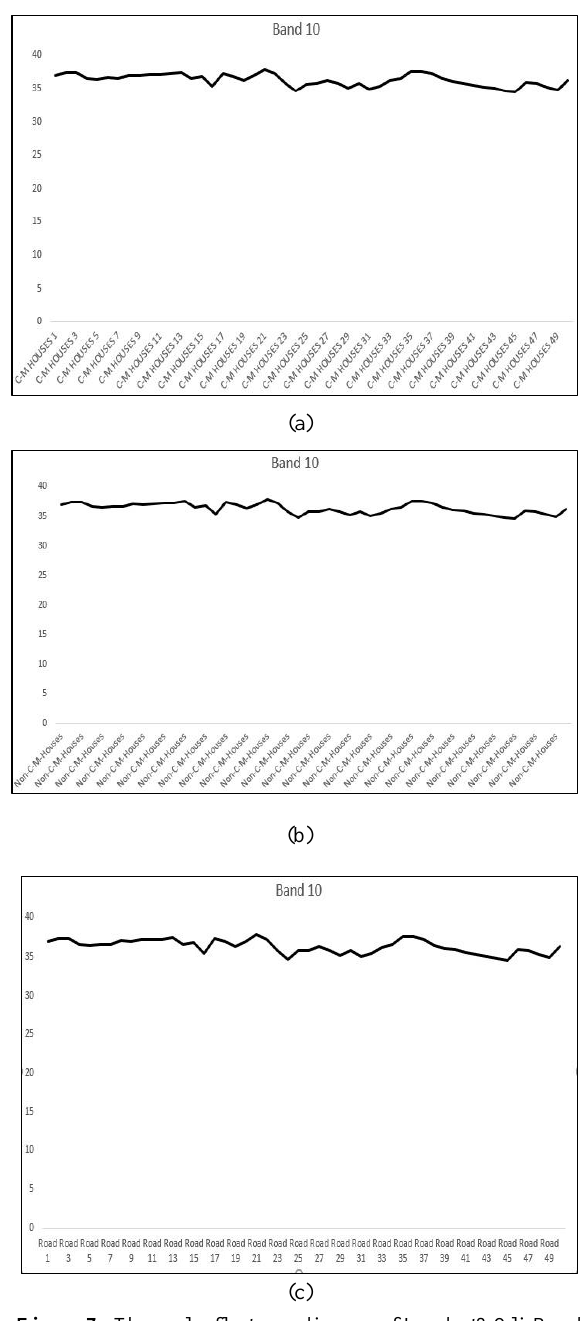
Figure 7. Thermal reflectance diagram of Landsat8-Oli, Band 10: (a) Clay Made-House, (b) Non Clay-made House, (c) Road.